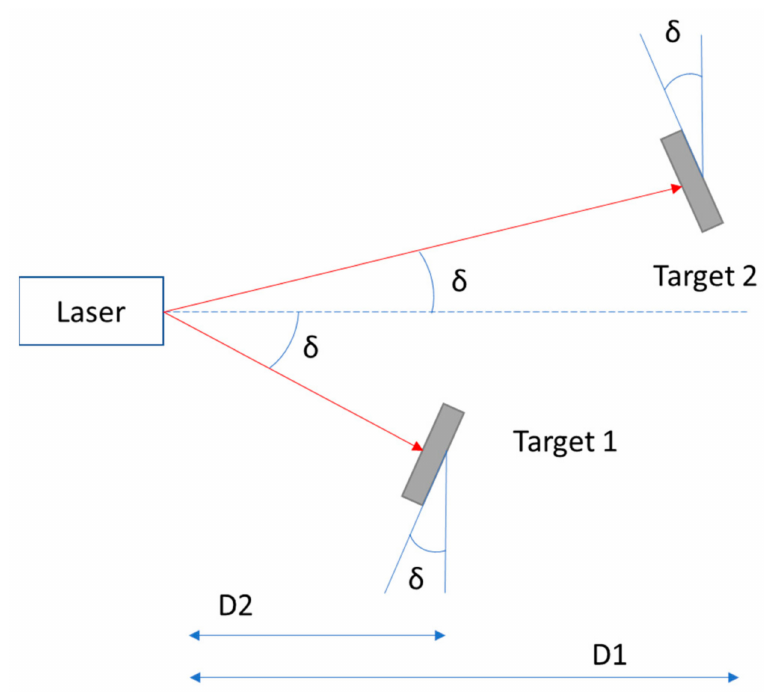
Figure 26. Laser transmission measurement technique